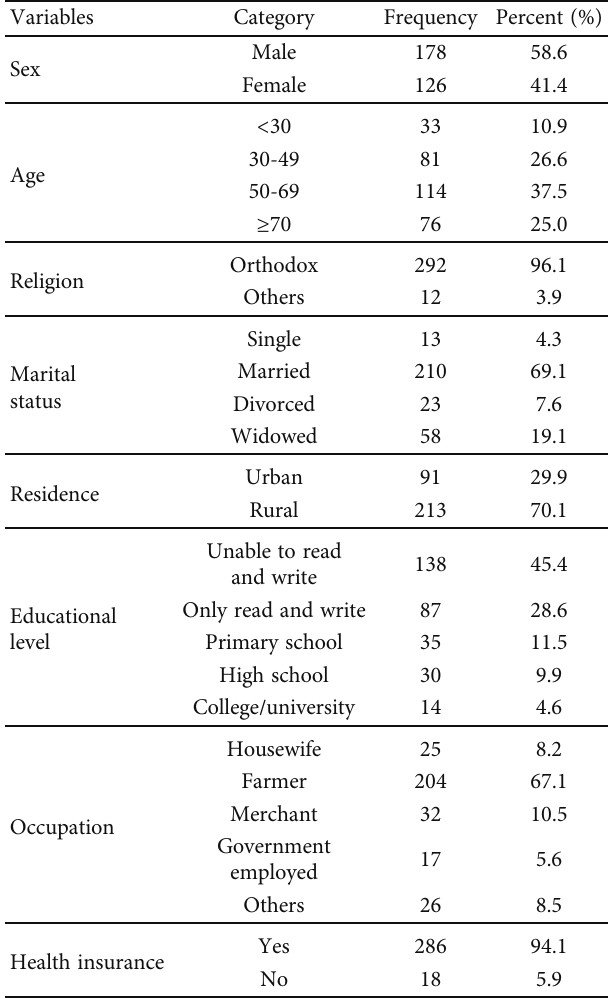
Table 2: Clinical characteristics of HF patients in West Gojjam Zone public hospitals, Northwest, Ethiopia,